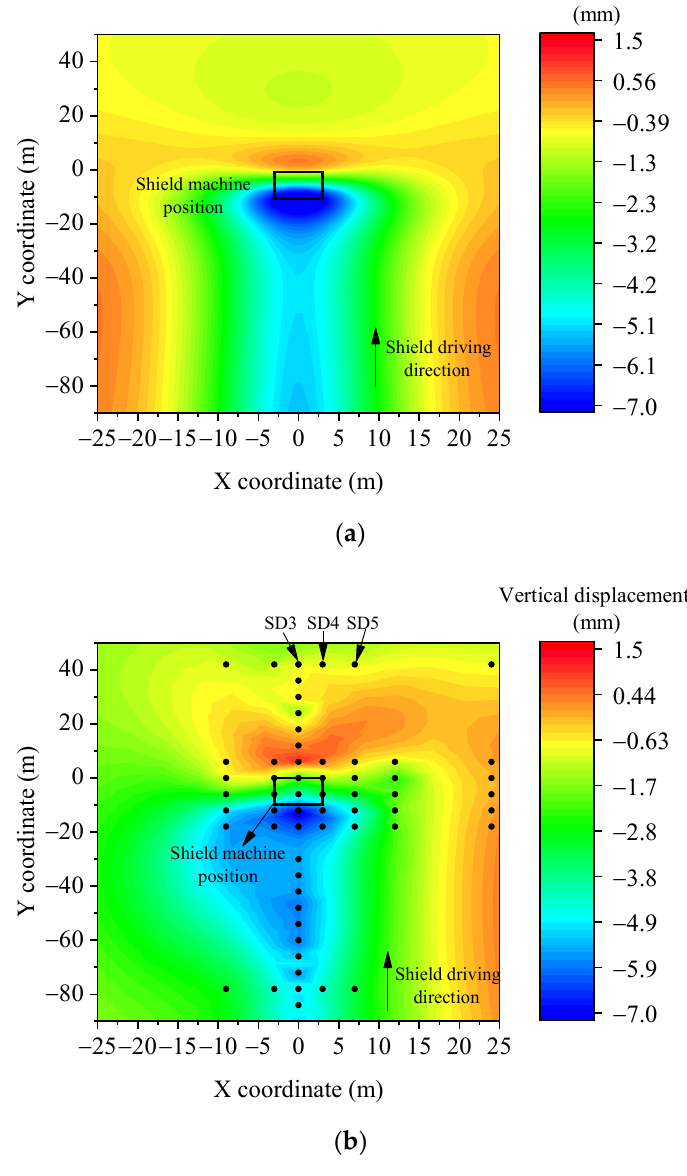
Figure 15. Comparison of predicted and monitored ground surface displacement in case B. ( a ) predicted displacement; ( b ) monitored displacement.